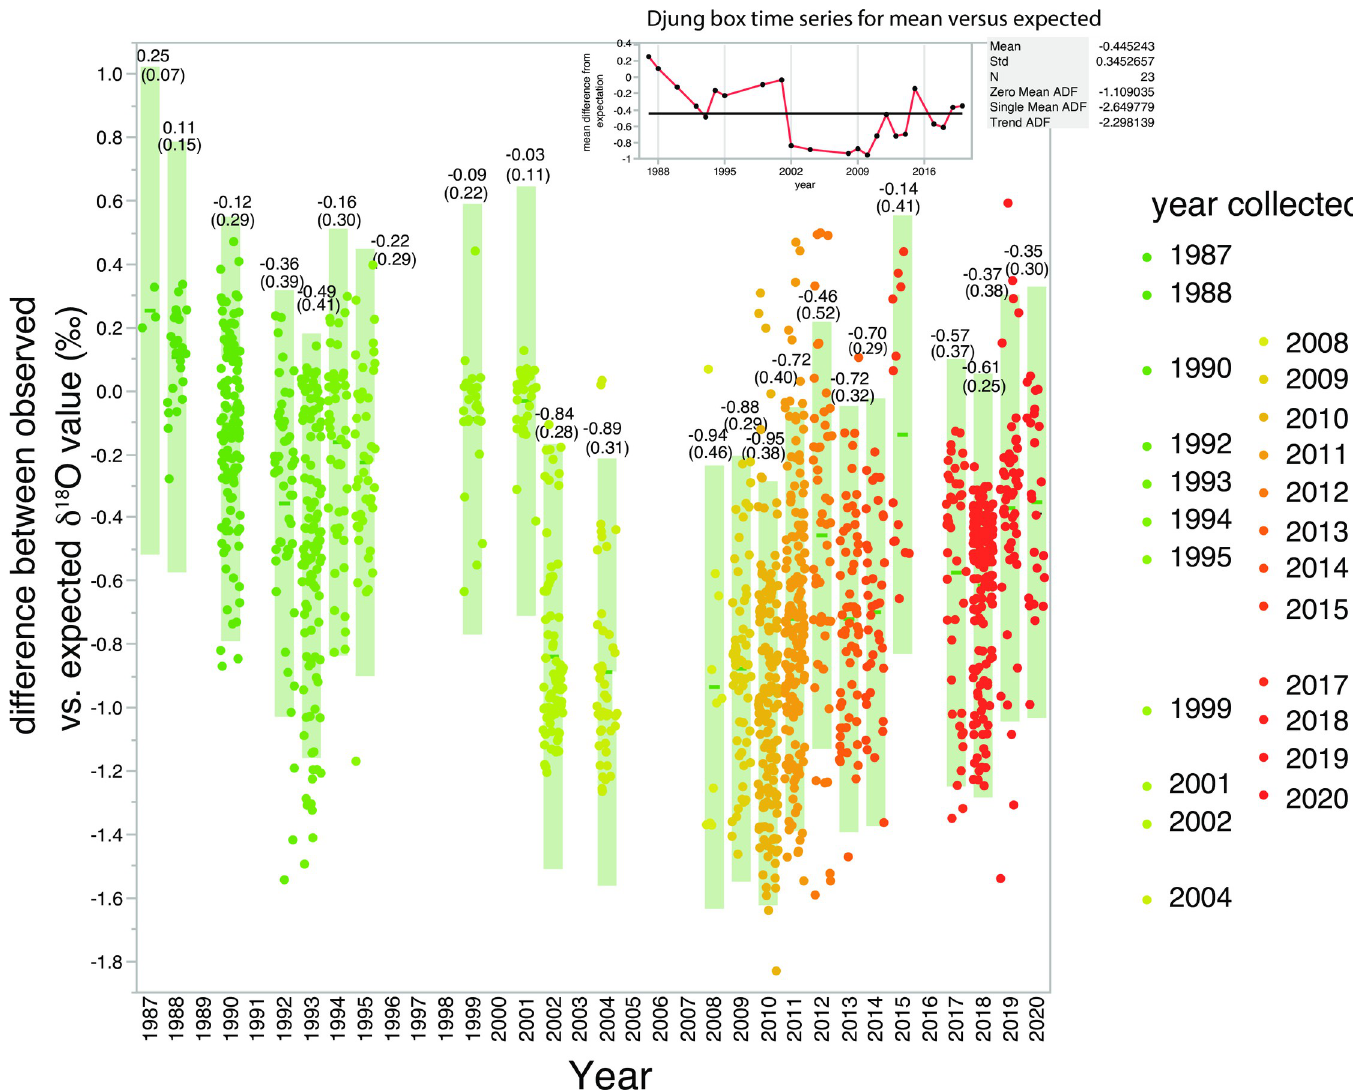
Fig 5. Data distribution by year with difference between expected δ 18 O value, based upon δ 18 O = Salinity � 0.59–20.0‰ (Eq 3; see text) versus the actual observed δ 18 O values for the observed salinities. Light shaded columns are confidence intervals associated with the mean deviation from the expected δ 18 O values. Numbers associated with each column are the mean deviation in observed samples from the expected δ 18 O values projected from Eq (3). Numbers in parenthesis are ± 1 SD. Range of color coding of δ 18 O values by years as described previously in Fig